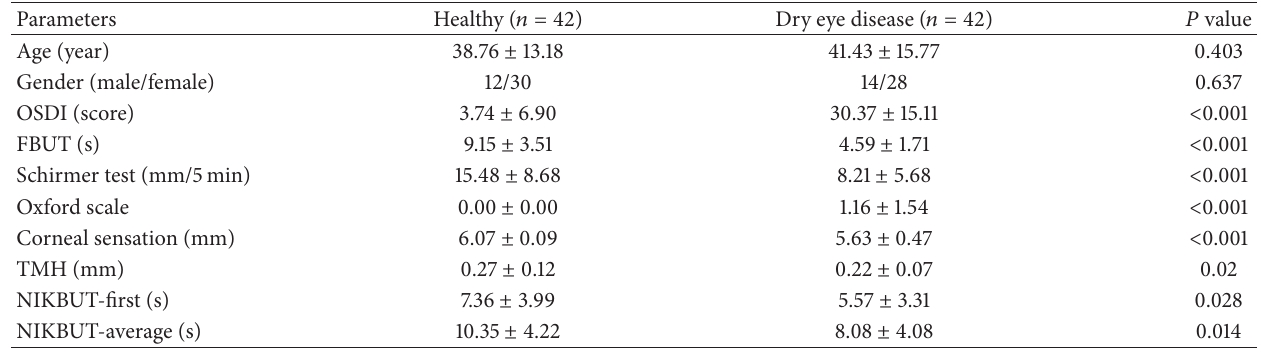
Table 1: Characteristics of the study